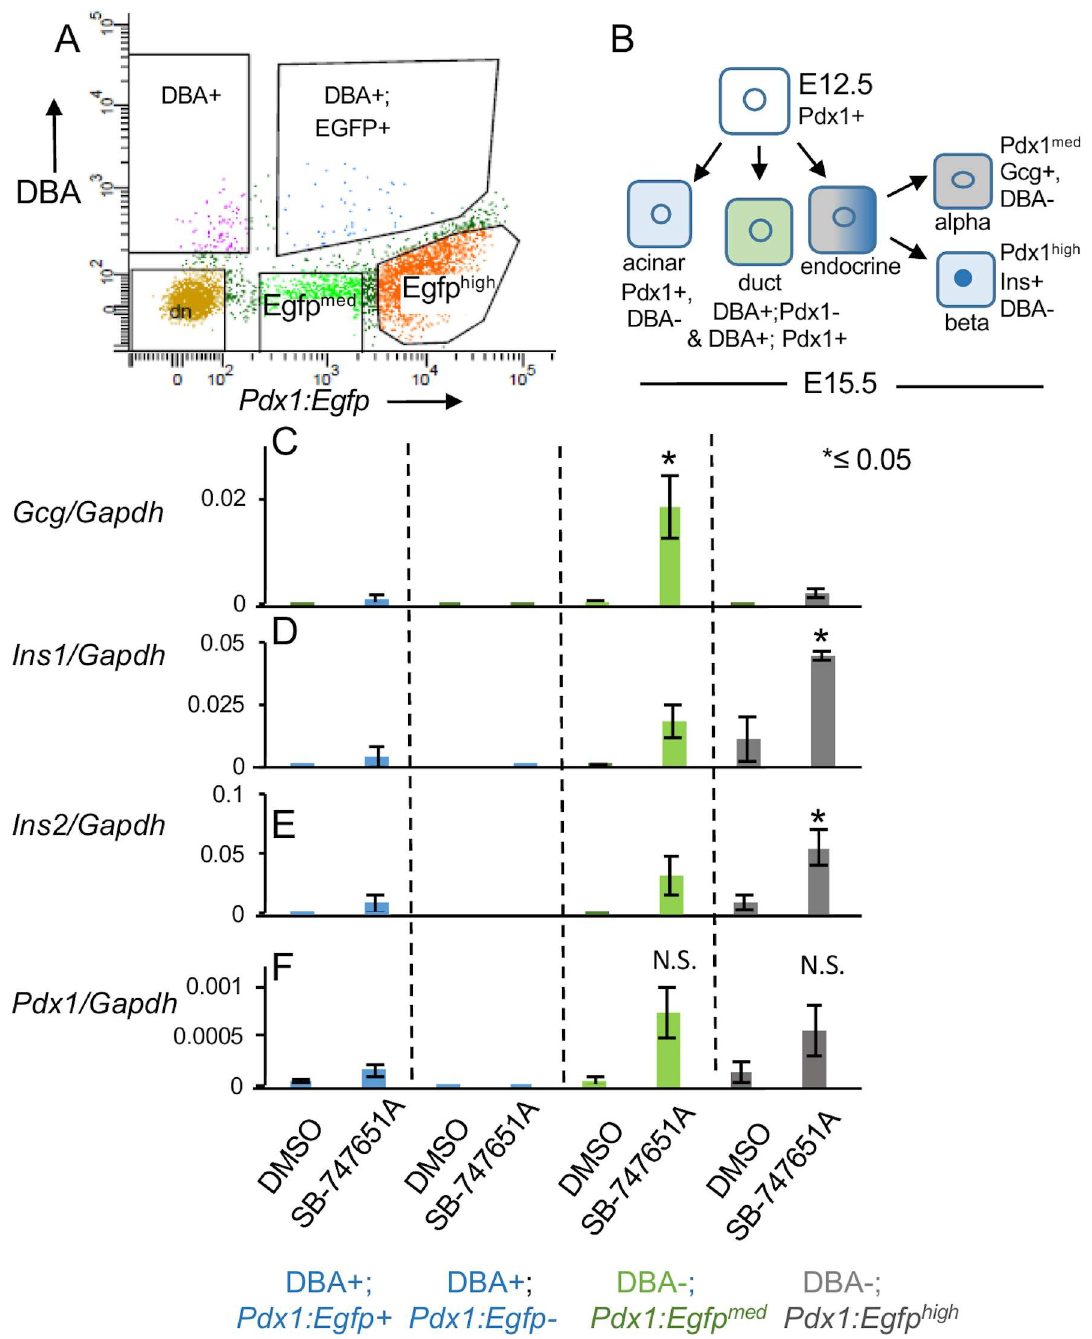
Fig 8. Enhancement of endocrine genes upon SB-747541A treatment is independent of intercellular interactions. (A) Scatter plos of cells from E15.5 pancreata, sorted by FACS into Egfp and rhodamine conjugatedDBA positive cells. (B) Hierarchyof different lineagesduringpancreaticdevelopment indicatingexpressionof DBA and Pdx1-Egfp. (C-F) Normalizedexpressionof indicatedgenes on third day of culture of different FACS sorted populationstreated with either DMSO or SB-747651A. n (cid:21) 25 pooledpancreata for each biological replicate, n = 2 biologicaland 3 technicalreplicates, P- values = 0.01 for Gcg in DBA-; Pdx1 : Egfp med , 0.01 and 0.009, respectivelyfor Ins1 and Ins2 , in DBA-; Pdx1 : Egfp high cell sub- population.Valuesare averages of independent experiments ± standarderror unless otherwisestated. All P-valueswere calculatedby Student’s t test, comparingDMSO and SB-747651A treated samplesin independentexperiments, * (cid:20) 0.05, ** (cid:20) 0.01, *** (cid:20) 0.001, two-tailed.